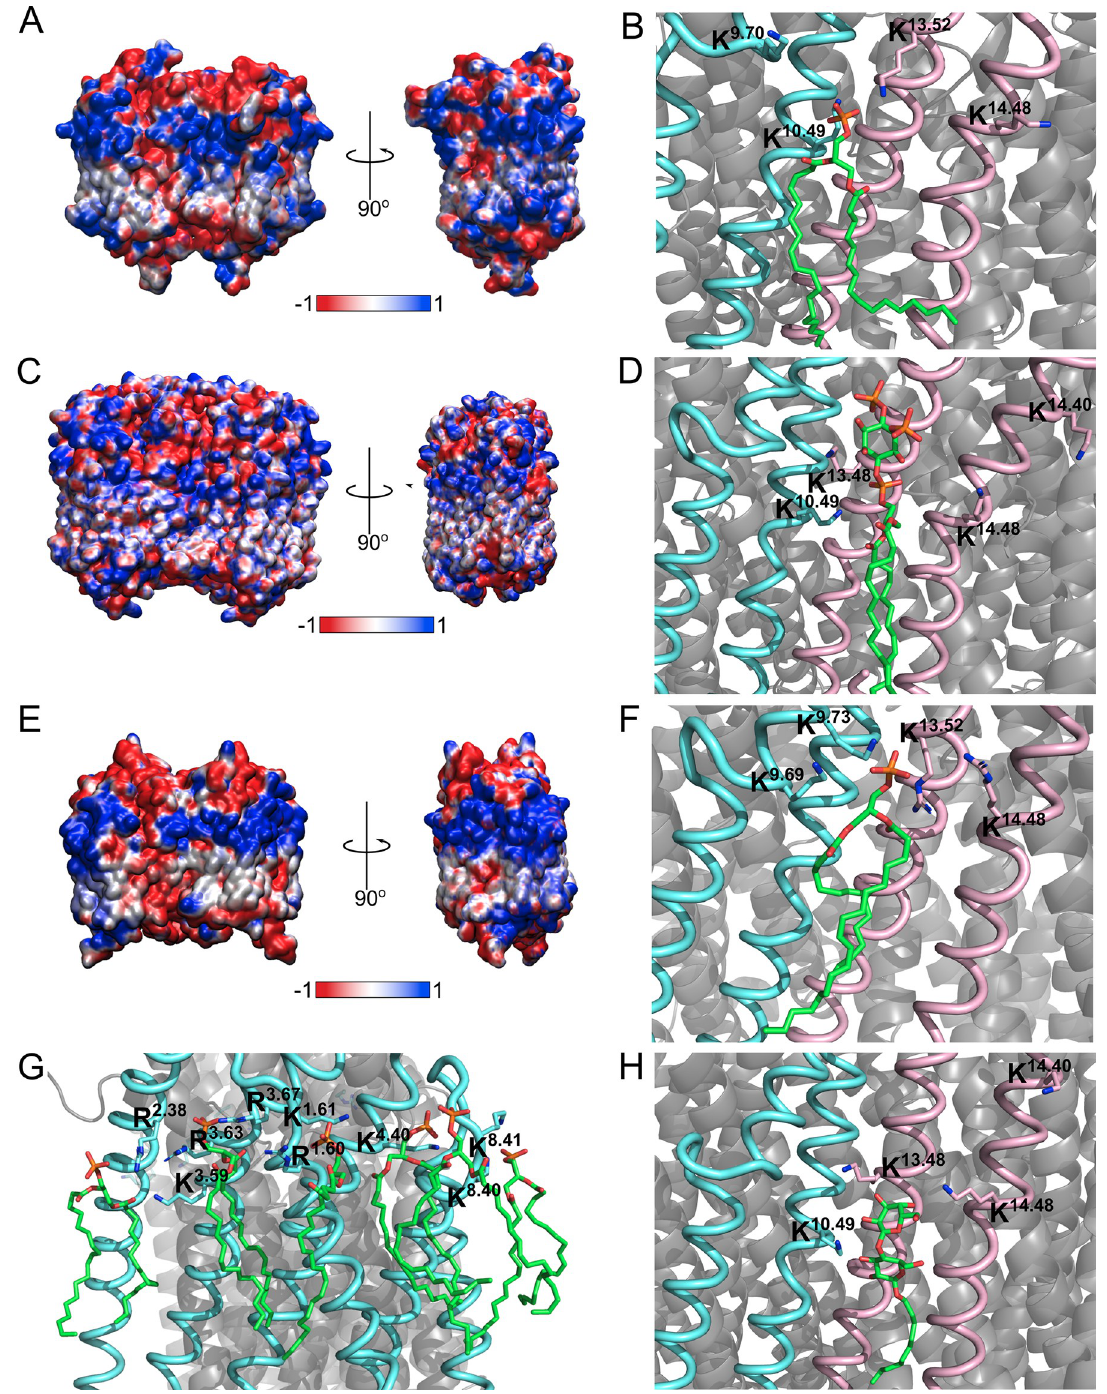
Fig 4. Electrostatic profiles and arrangements of the mPPases lipid binding sites. The electrostatic profile as calculated by APBS and structural arrangement of the A-B) Tm- PPase, C-D) Vr- PPase and E-F) Cp- PPase protein interfacial anionic lipid binding site with POPA (green sticks) or PIP 2 in the case of Vr -PPase bound and the interacting lysines or arginines shown as sticks. The snapshots are the final frame of one of the CG simulations (at 5 μ s of simulation) converted to an atomistic representation. G) The distal interaction site of Tm- PPase, and H) the arrangement of a DM detergent molecule (green sticks) in the crystal structure of Vr- PPase (PDB: 4A01).